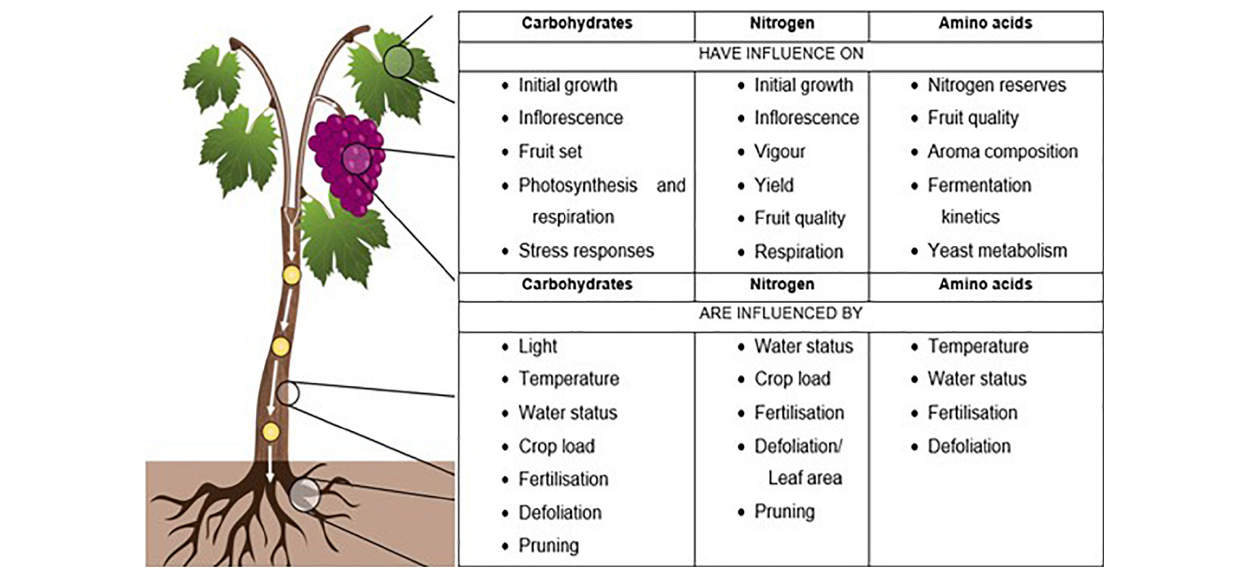
FIGURE 1 | Summary of viticultural, physiological, environmental, and oenological factors that have an influence on, or are influenced by the key metabolites [Adapted from Noronha et al.